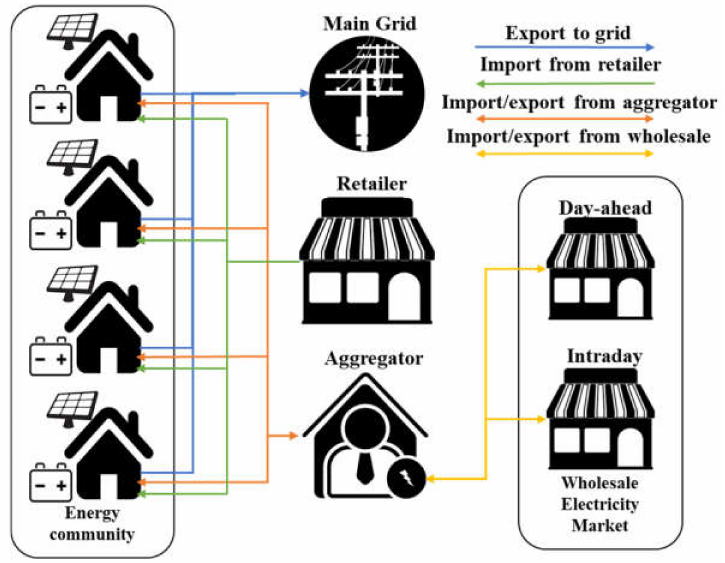
Figure 1. Proposed